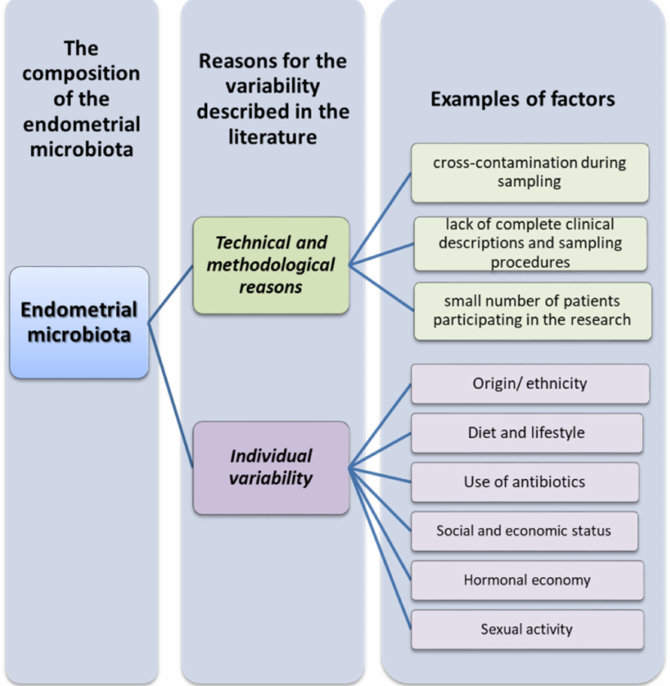
Figure 4. Reasons for the variation in the composition of the endometrial microbiota (based on